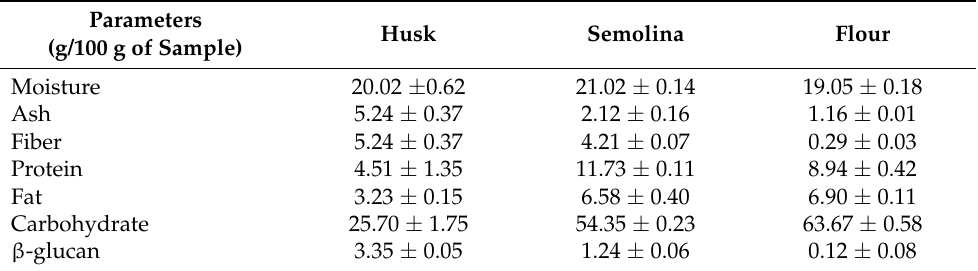
Table 2. Physicochemical composition and β -glucan content of oat fractions after milling. Parameters Husk Semolina Flour (g/100 g of Sample) Moisture